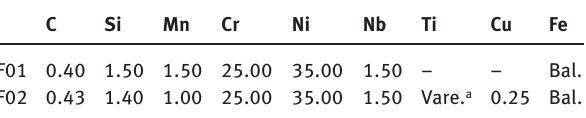
Table 12: Chemical composition of analyzed alloys